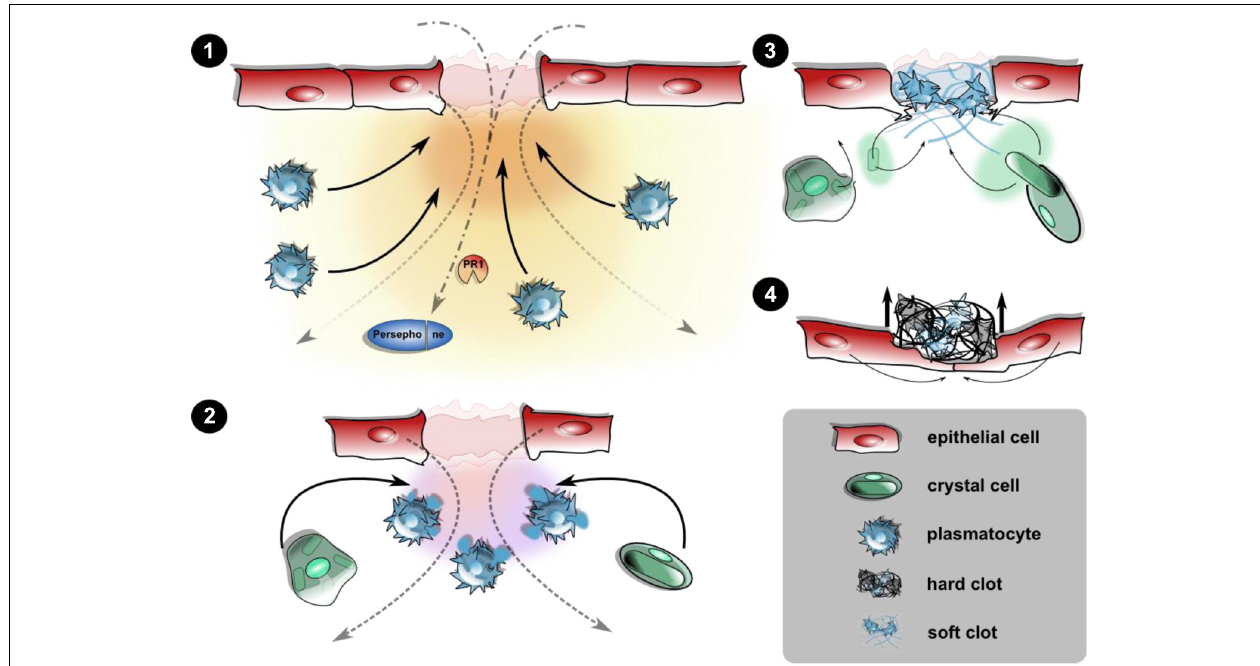
FIGURE 1 | Cellular and humoral responses upon epithelial wounding. Disruption of the epidermis and the larval cuticle (omitted for simplicity) initiates an immediate response prior to wound healing leading to the closure of the wound site. (1) Wound signals attract hemocytes: the destructed epithelial layer releases yet unidentified damage signals creating a gradient along which plasmatocytes are recruited toward the wound site. This may be actively including the release of hemocytes from the sessile compartment or passive capture of hemocytes from the hemolymph. Wound sites serve as entry ports for pathogens too, leading to activation of PRRs and damage receptors like Persephone. (2) Degranulation and soft clot formation: at the wound site, plasmatocytes degranulate initiating the